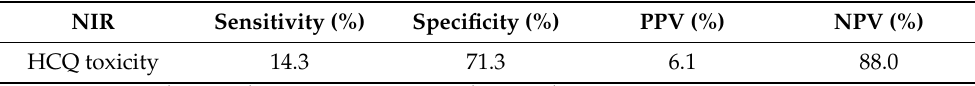
Table 3. Sensitivity and specificity of NIR imaging in detecting bull’s eye maculopathy.